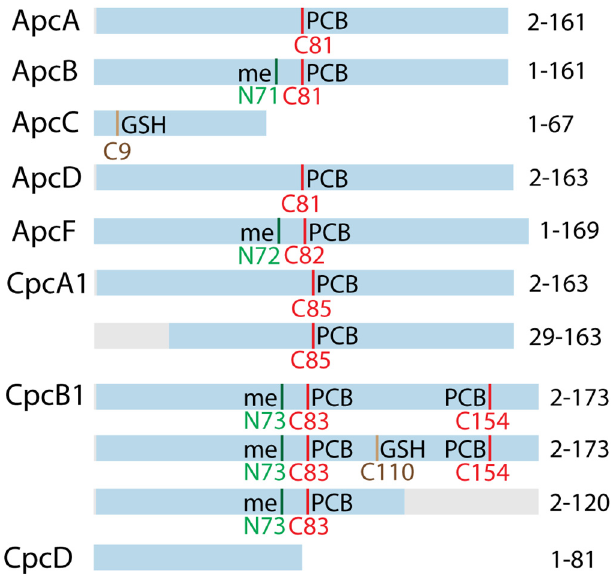
Figure 4. Summary of identified proteoforms of PBS proteins with top-down proteomics, including putatively assigned modifications based on mass shift detected in experimental data in this study and the information in UniProt (PCB—phycocyanobilin (red line), GSH—glutathione (brown line), me—methylation (green line). The blue bars represent the regions of the proteins detected experimentally, the gray bars are the regions that were truncated. PCB is detected at many different masses as discussed in Figure 3. A detailed list of proteoforms is included in Table S2.